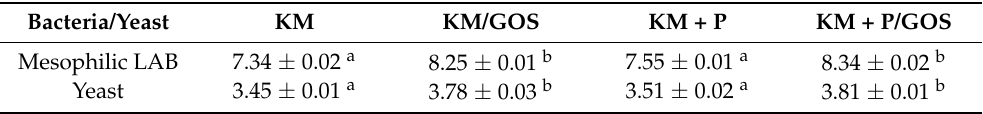
KM—goat’s milk; KM/GOS—goat’s milk after enzymatic conversion of lactose; KM + P—goat’s milk with permeate; KM + P/GOS—goat’s milk with permeate after enzymatic conversion of lactose. Values represent mean ± SD ( n = 7); SD—standard deviation; a,b , different letters with mean values in a row indicate statistically significant differences at the level α =